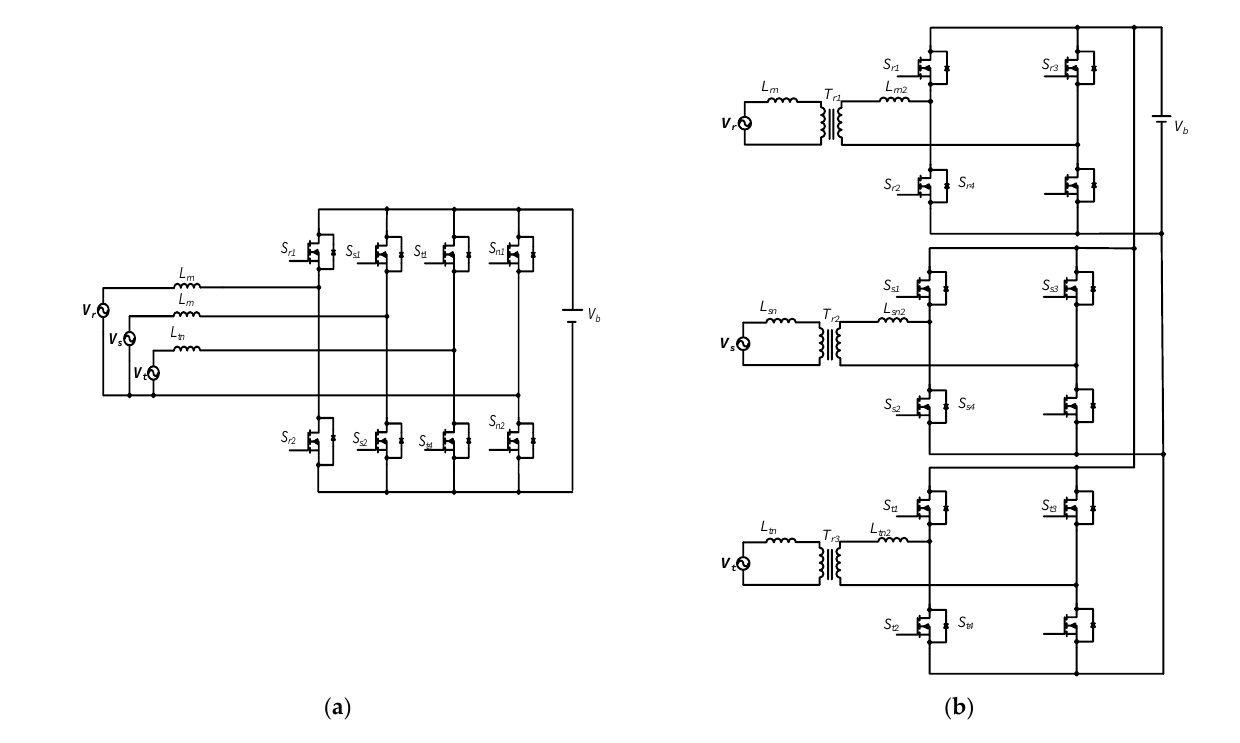
Figure 2. Three-phase inverter for an unbalanced ac grid system: ( a ) four-leg inverter topology; ( b ) three individual H-bridge inverters.